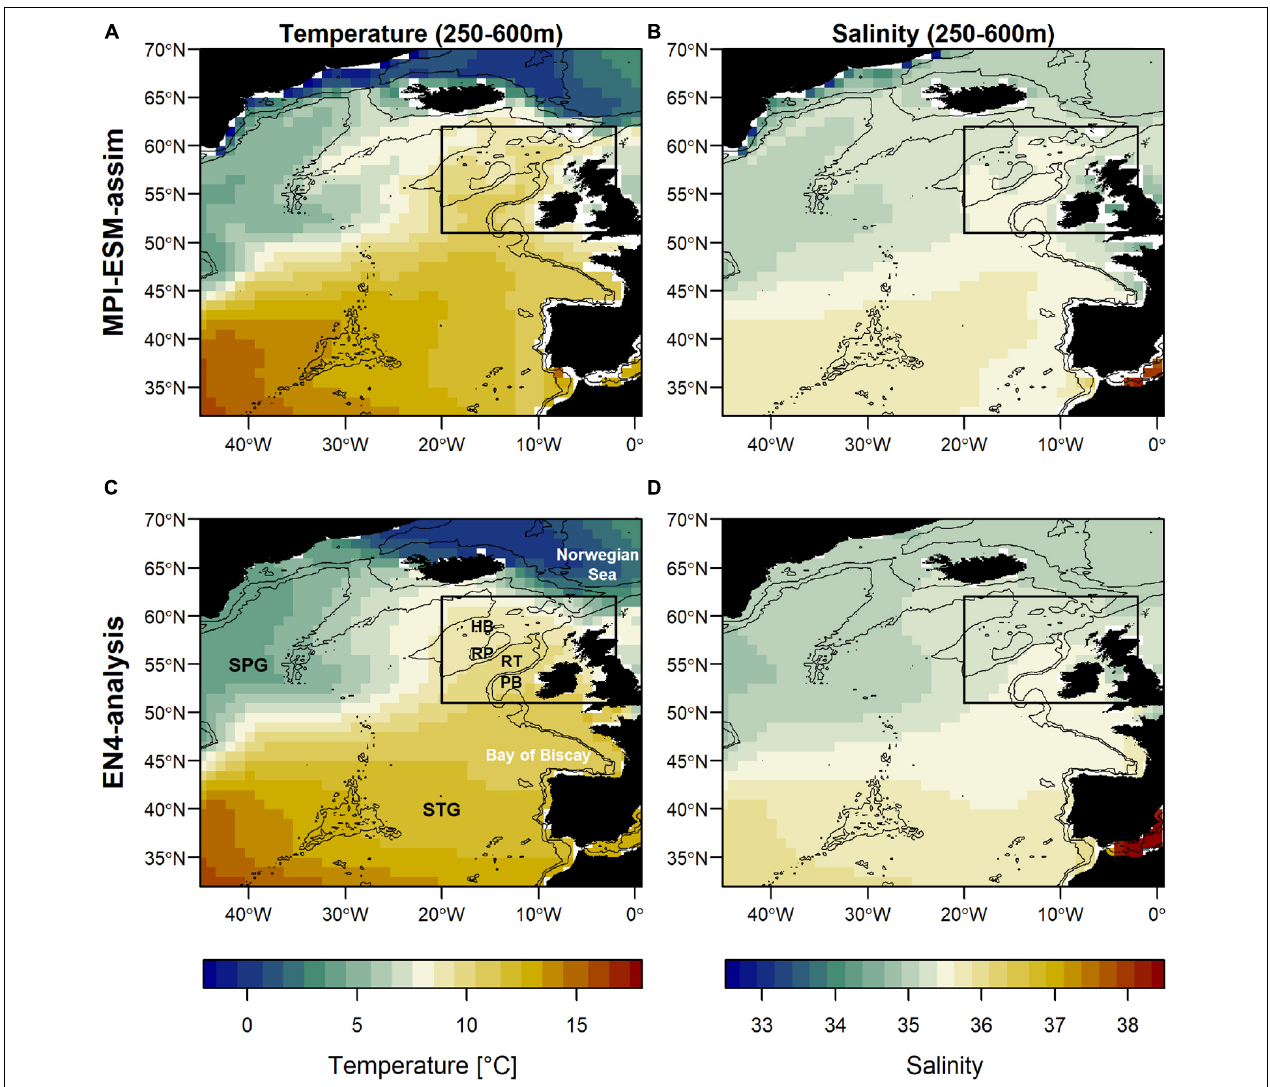
FIGURE 1 | Mean oceanographic conditions in February, March and April (FMA; climatology of 1965–2016) within the spawning depth of blue whiting (250–600m) in terms of temperature (left; A,C ) and salinity (right; B,D ) for MPI-ESM-assim (top; A,B ) and EN4-analysis (bottom; C,D ). The black rectangle delineates the study area: the spawning region of blue whiting. Labels in panel (C) show the geographic features Hatton Bank (HB), Rockall Plateau (RP), Rockall Trough (RT), Porcupine Bank (PB), and the two dominant gyre systems North Atlantic subpolar gyre (SPG) and the subtropical gyre (STG). Bathymetry is indicated by 600 and 2000 m